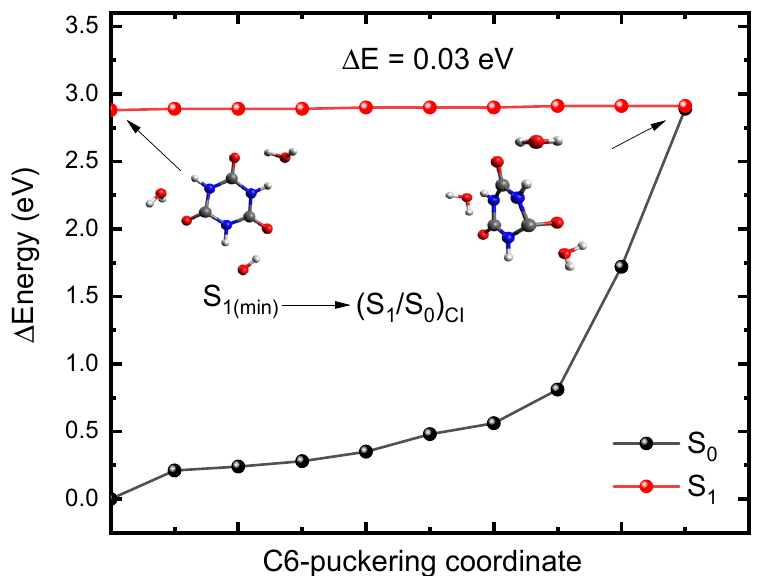
Figure 4. Potential energy profiles between the S 1 minimum-geometry and the (S 1 /S 0 ) CI along